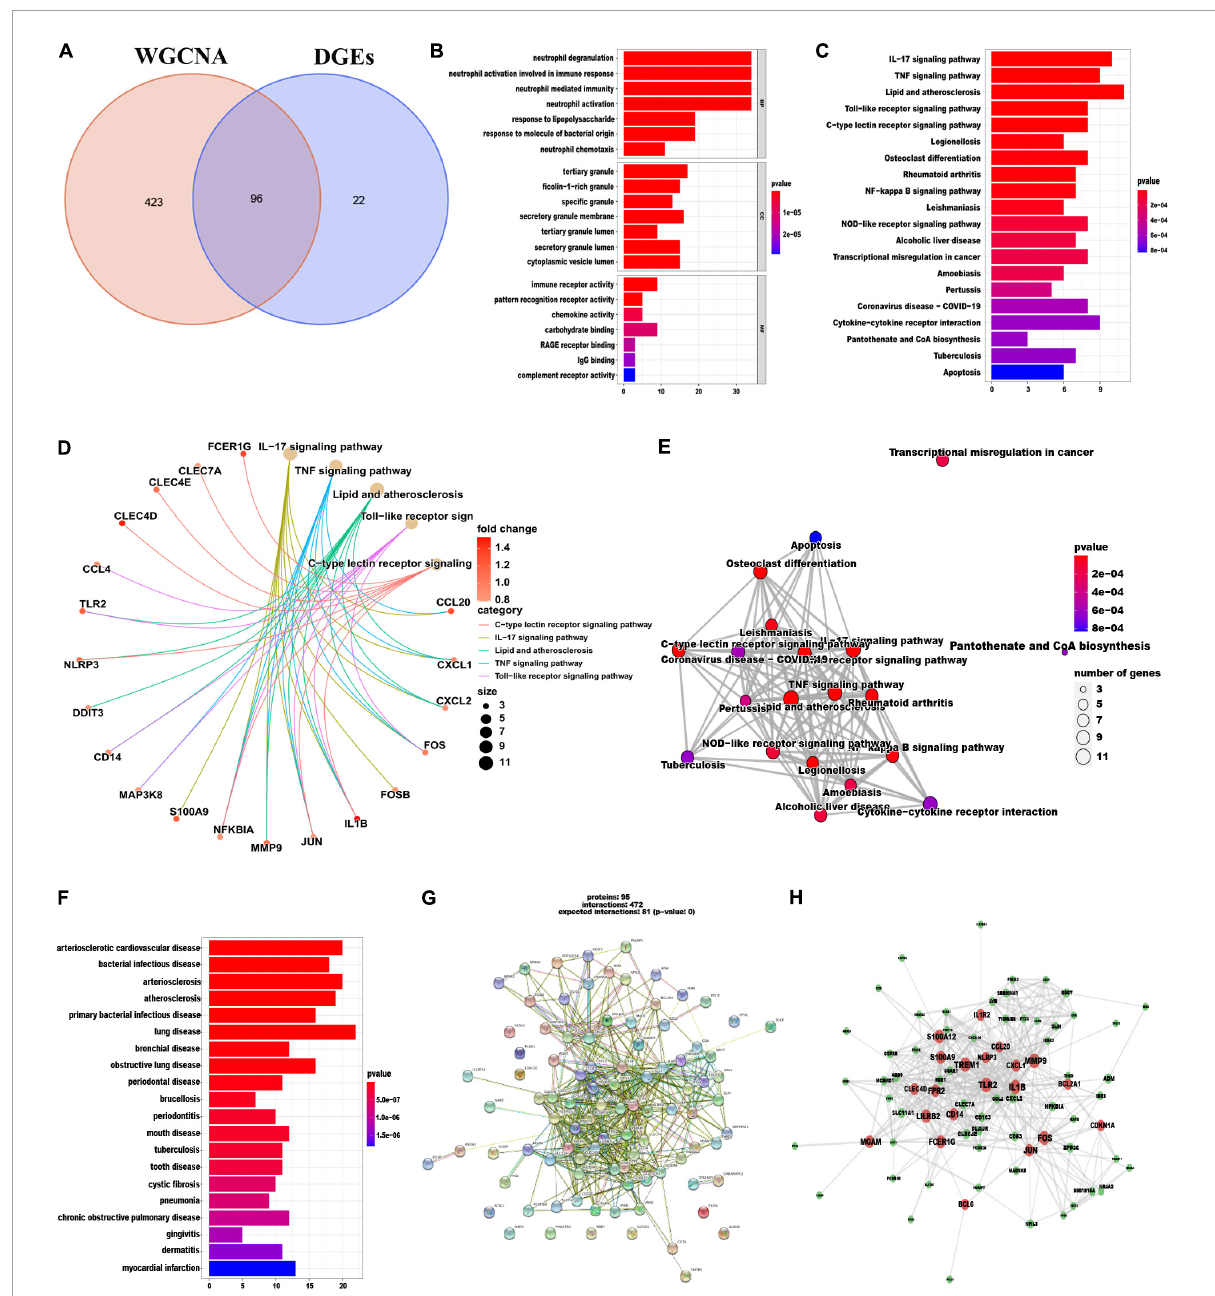
FIGURE4 Identification and functional enrichment analyses of overlapping candidate genes. (A) Venn diagram showed the intersection of DEGs and module genes of WGCNA. (B–F) GO (B) , KEGG (C–E) , and DO (F) enrichment analysis of the overlapping candidate genes. (G) Protein-Protein Interaction (PPI) network of overlapping candidate genes. (H) The co-expression network showing correlation intensity of hub genes from overlapping candidate genes.